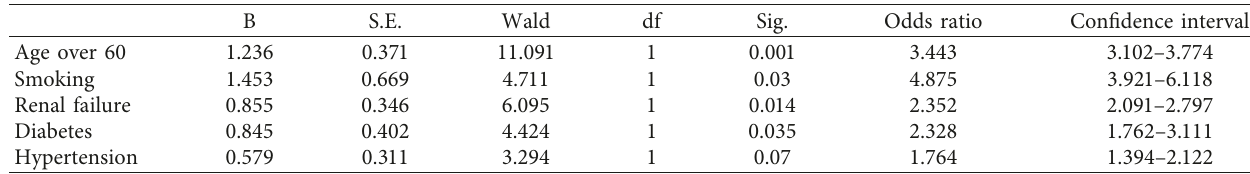
Table 4: Multivariable logistic regression analysis of the risk factors involved in the presence of radial calcinosis.